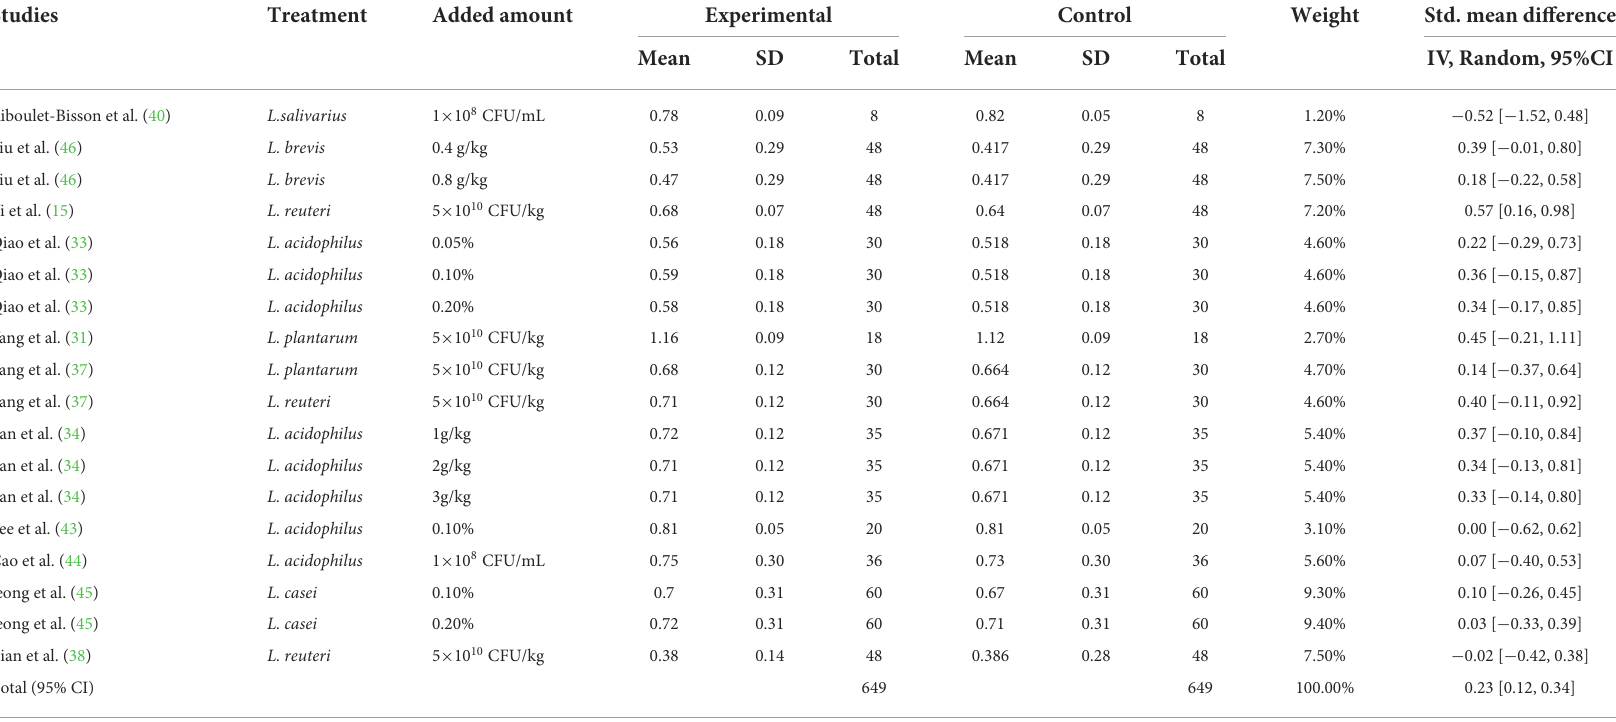
TABLE 4 Effects of Lactobacillus –based probiotics on the gain to feed (G/F) ratio of pigs from included